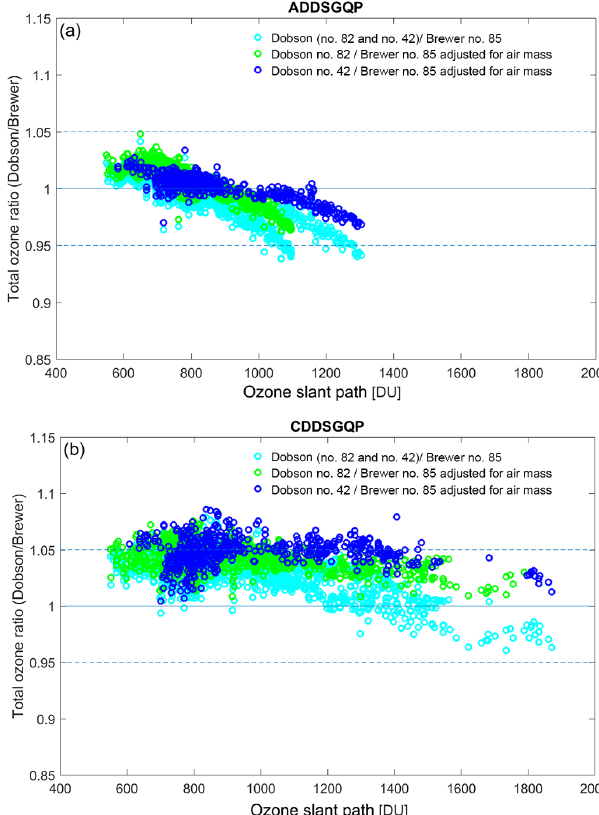
Figure 9. (a) The ratio of quasi-simultaneous observations (within 5min) using Dobson (no. 82 and no. 42) AD wavelengths to double Brewer no. 085 data at the South Pole for total ozone values larger than 220DU. (b) Same as (a) using Dobson CD pairs. Brewer air masses have been corrected using the values used for the Dobson measurements for the radius of the Earth, ozone layer height, and the altitude of the site. The ratios of all data from three Dobson in- struments and Brewer data before adjustment for ozone layer height and station altitude are also depicted. ADDSGQP: AD direct sun measurement using a ground quartz plate, and CDDSGQP: CD di- rect sun measurement using a ground quartz plate.